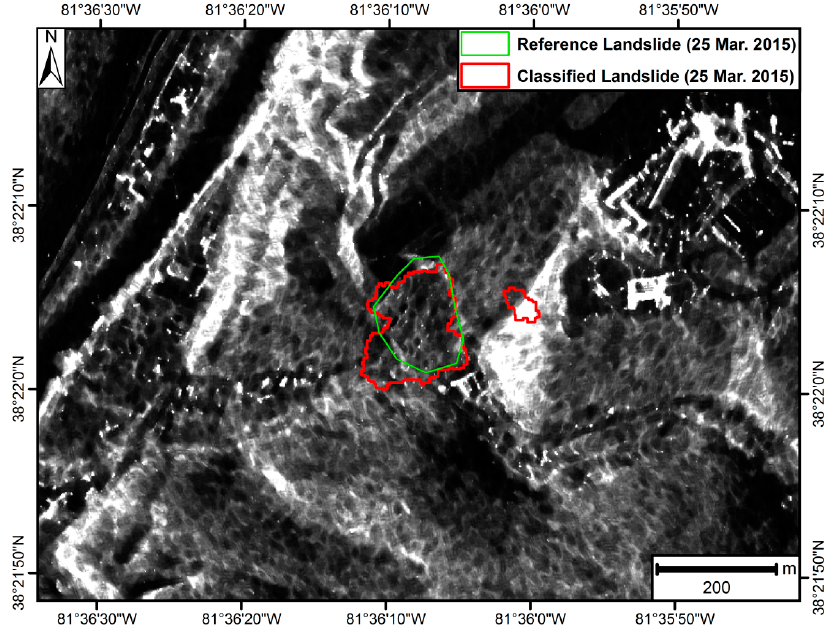
Figure 4. Overview image of the Yeager Airport landslide. TerraSAR-X data acquired on 25 March 2015 serves as background image. The orange box shows the area of the Figures 5 and 6. TerraSAR-X © 2015 German Aerospace Center (DLR), 2015 Airbus Defence and Space/Infoterra GmbH.